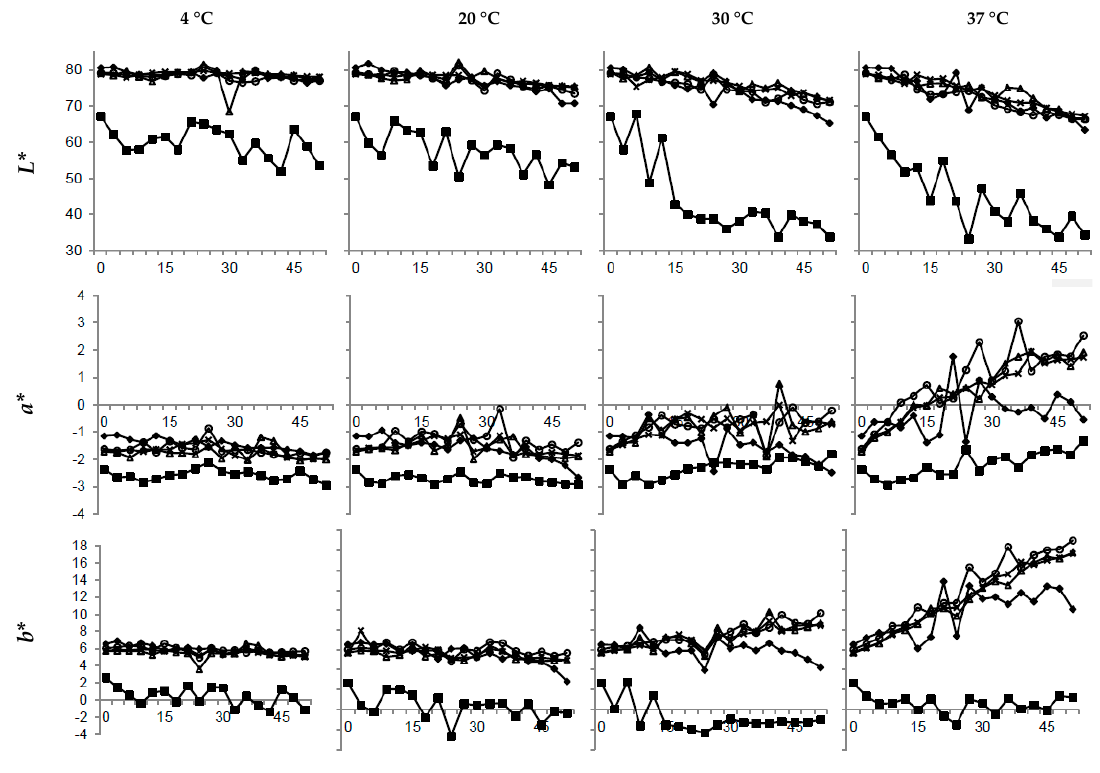
Figure 3. Variation in L * (lightness), a * (green-red), and b * (blue-yellow) in ultra-high temperature treated milk for selected samples with elevated levels of ( ■ ) calcium, ( ○ ) citrate, ( ∆ ) urea, ( ♦ ) calcium and citrate, and average values of two batches ( × ) unmodified reference ultra-high temperature treated milk during storage from 0–52 weeks at 4, 20, 30, and 37 °C.